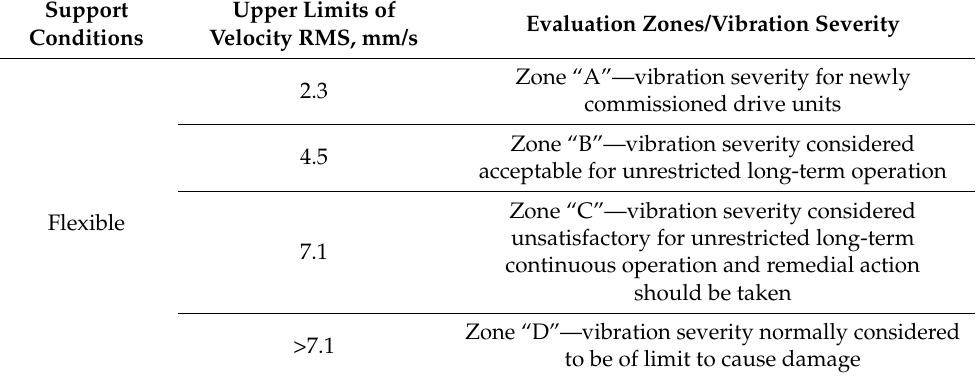
Table 1. Numerical values used for the qualitative assessment of the technical condition of the tested drive unit (according to ISO-10816-3) [27].